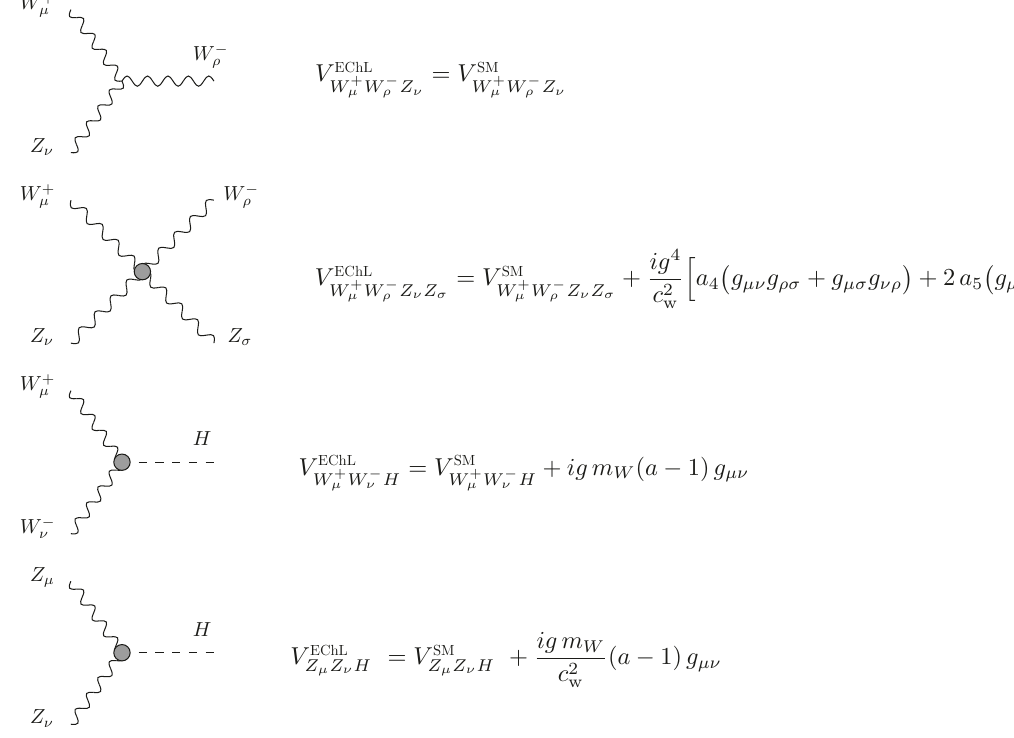
Figure 19 . Relevant Feynman rules for the WZ vertices that are sensitive to the chiral parameters a; a 4 and a 5 of our simpli(cid:12)ed scenario. We take all momenta as